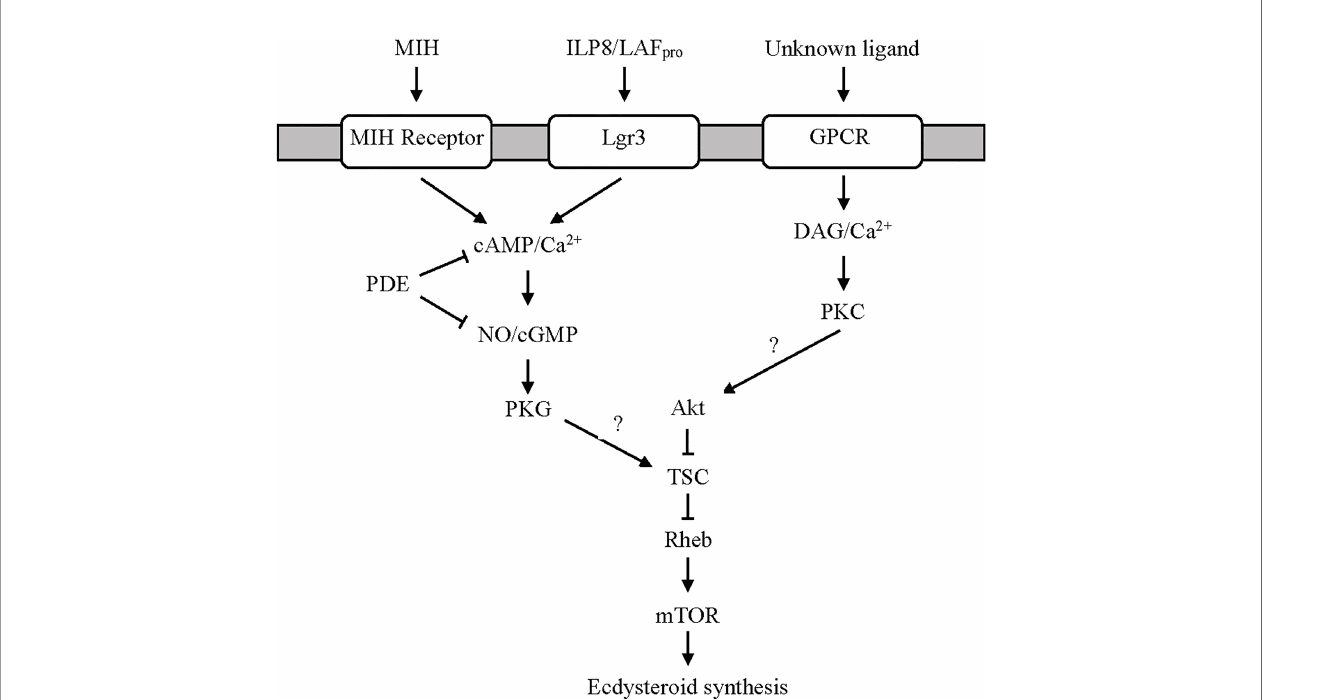
FIGURE 3 | Proposed G protein-coupled receptor-mediated signaling pathways regulating ecdysteroidogenesis in the YO. MIH and limb autotomy factor - proecdysis (LAF pro ) activate cyclic nucleotide/NO-dependent signaling via distinct receptors. It is hypothesized that LAF pro , secreted by secondary limb regenerates during early premolt, is an insulin-like peptide similar to dILP8 in Drosophila that binds to Lgr3. Cyclic phosphodiesterase (PDE) activity inhibits MIH and LAF pro signaling by hydrolyzing cAMP and cGMP to AMP and GMP, respectively. An unknown ligand, possibly serotonin or other biogenic amines (see Ca2+/Diacylglycerol/ Protein Kinase C Signaling Section), binds a GPCR to activate the Ca 2+ /diacylglycerol (DAG)/protein kinase C (PKC) pathway. Both pathways converge on mTOR signaling, possibly by phosphorylation of tuberous sclerosis complex (TSC) by protein kinase G (PKG) to inhibit ecdysteroid synthesis or by phosphorylation of Akt by PKC to stimulate ecdysteroid synthesis (2, 12, 50,